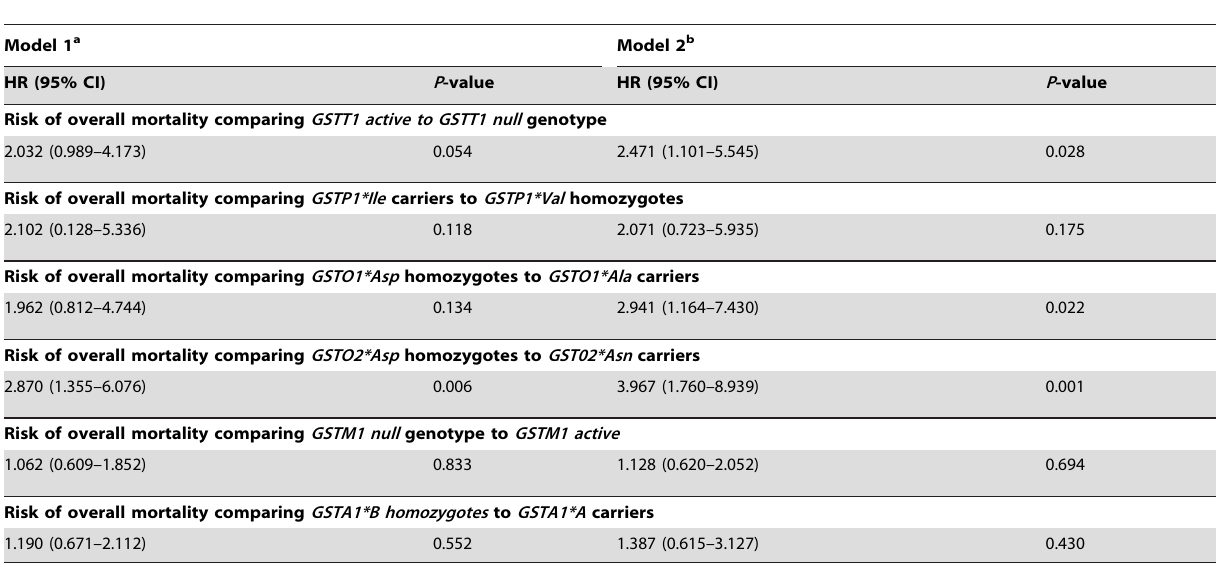
Table 3. GSTT1, GSTP1, GSTO1, GSTO2, GSTM1 and GSTA1 polymorphisms as the predictors for overall mortality among 101 patients with muscle invasive TCC after 5 yrs of follow-up by the Cox proportional hazards